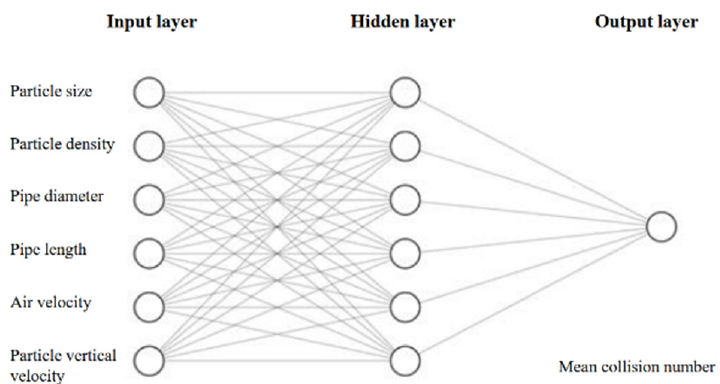
Figure 2. The architecture of the neural network used for fast computation of collision numbers using six input parameters and a hidden layer with six neurons.